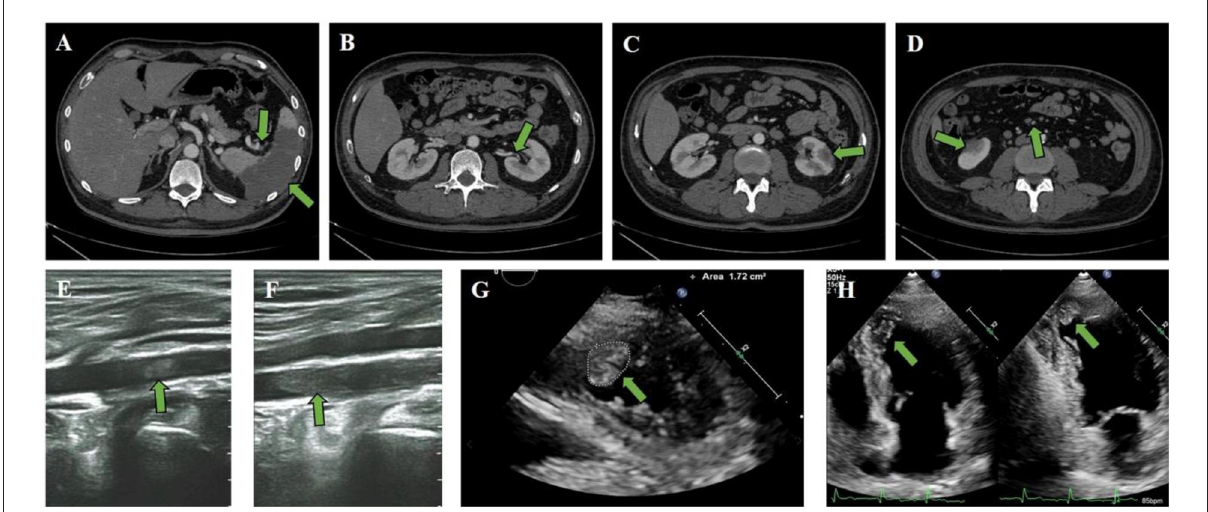
FIGURE1 Clinical CT scan and ultrasound imaging. (A–F) Enhanced CT scan revealed (A) splenic infarction and splenic artery thrombosis, as well as (B) left renal artery embolization, (C) left renal infarction, and (D) superior mesenteric artery thrombosis and right renal infarction. Ultrasonography of the lower limb artery revealed (E) right popliteal artery thrombosis and (F) left posterior tibial artery thrombosis. (G,H) The attached thrombus (size 1.13 × 1.77cm and area 1.72 cm 2 ) was observed in the apex part of the LV.